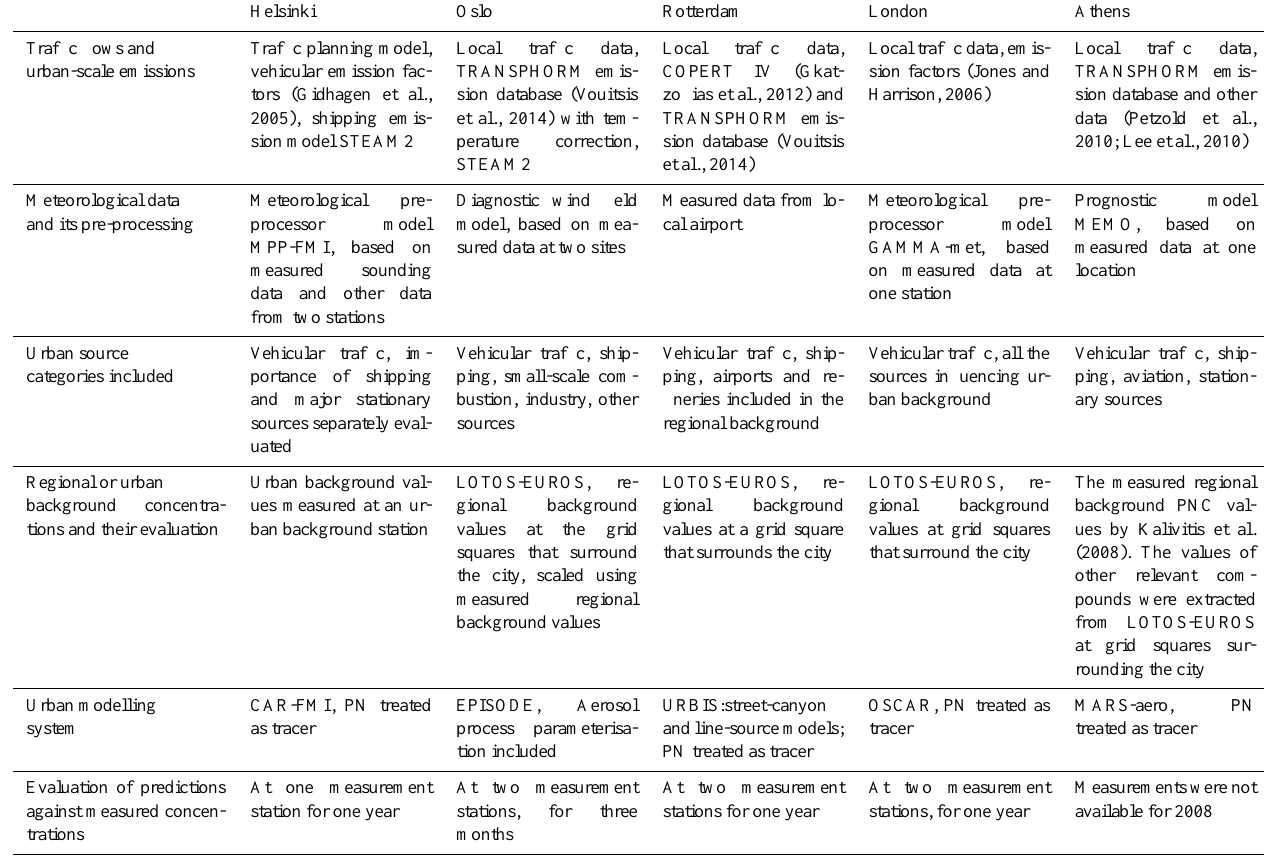
Table 1. Overview information on the computational methods and the evaluation of predictions in the five target cities for